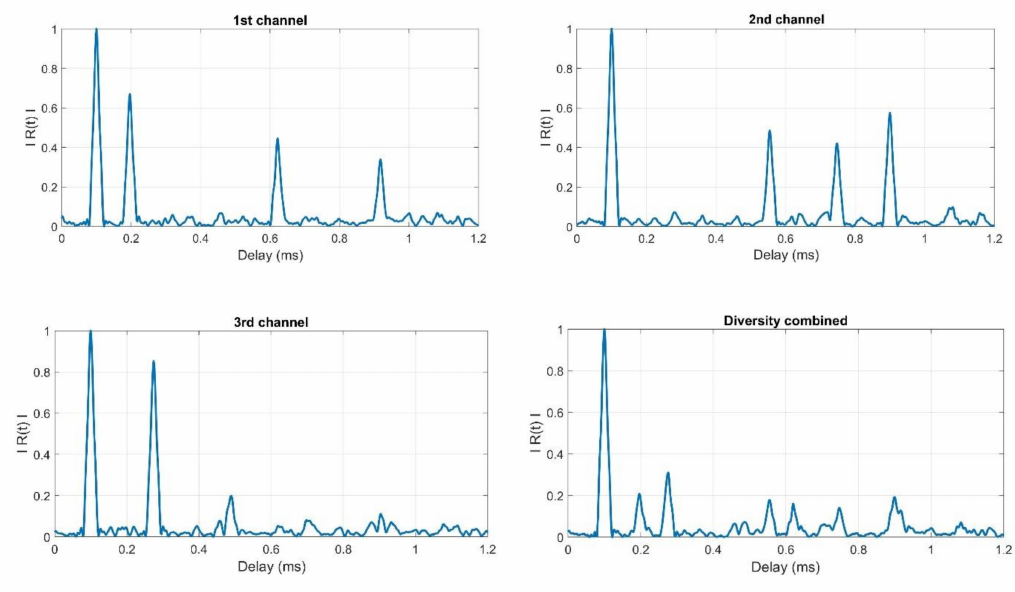
Figure 7. Example showing the impact of diversity combining on the estimate of the hydroacoustic channel impulse response